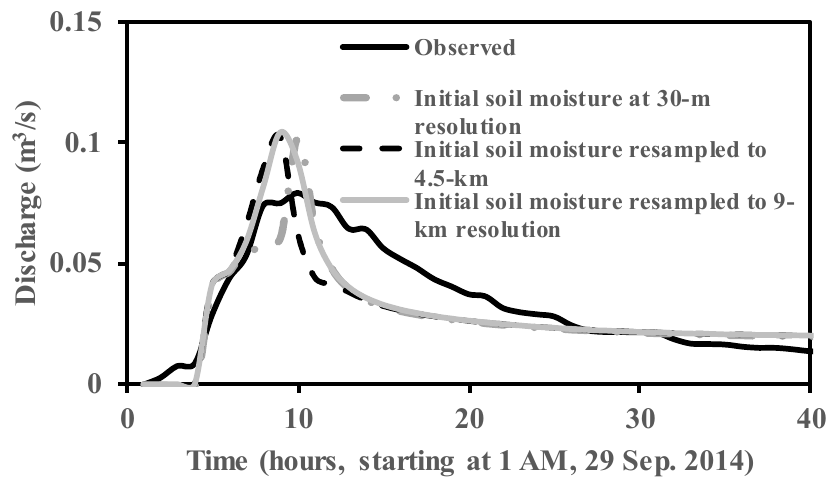
Figure 11. Recalibrated hydrographs with resampled initial soil moisture.